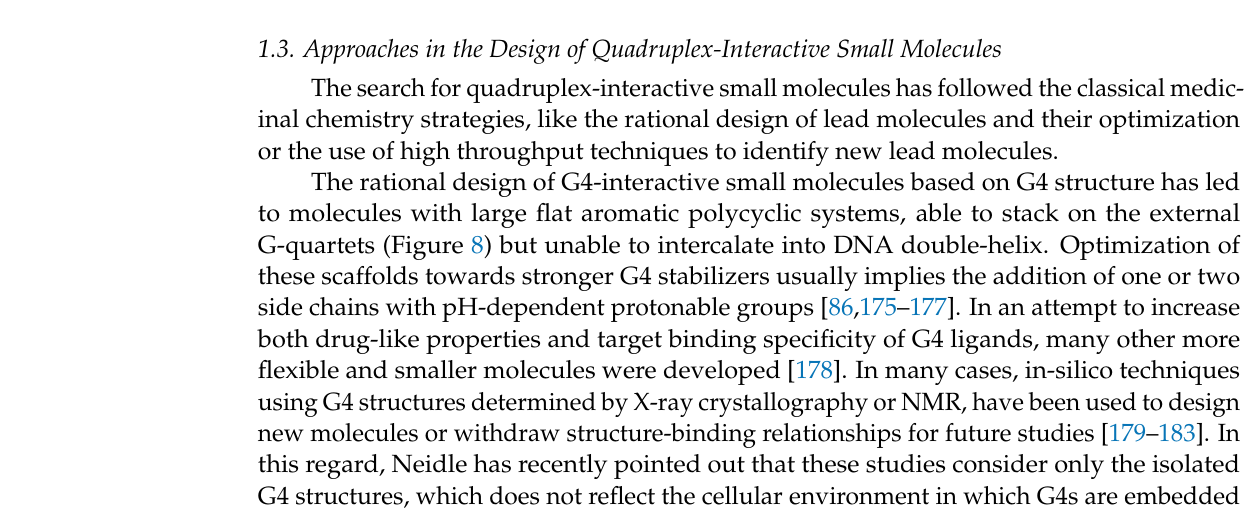
Structure in Virus Effects Refs. Figure Reduced EBNA1 synthesis and recognition of EBV-infected EBV cells by virus-specific T cells. HBV Enhanced preS2/S gene promoter activity. Inhibited mRNA synthesis, virus cytopathic effect and viral ZIKV NS2B-NS3 protease activity in infected Vero cells, particularly during postinfection treatment. Promoted viral RNA polymerase stalling. HCV In-vivo G4-mediated antiviral activity in the low microM range. SARS- Inhibited translation of nucleocapsid protein N, in-vitro and CoV-2 in-vivo. Reduced viral titre by 2 log, acting at the viral DNA replication stage. Inhibited nucleolin binding to EBNA1 mRNA G4s and increased the endogenous EBNA1 levels in EBV-infected cells. Inhibited viral DNA replication by stalling the replication KSHV fork at the TR level; consequent reduction of viral episome copy numbers. HCV Inhibited viral replication in cells. Inhibited in-vitro the SUD-NM/TRF2 G4 interaction with an SARS-CoV-2 IC 50 = 51 nM. Reduced viral titers in-vitro, with downregulation of TMPRSS2 expression, a transmembrane serine protease essential for virus entry into the host cells Antiviral activity; reduced expression of TMPRSS2 and AC2; SARS-CoV-2 inhibited TMPRSS2 enzymatic